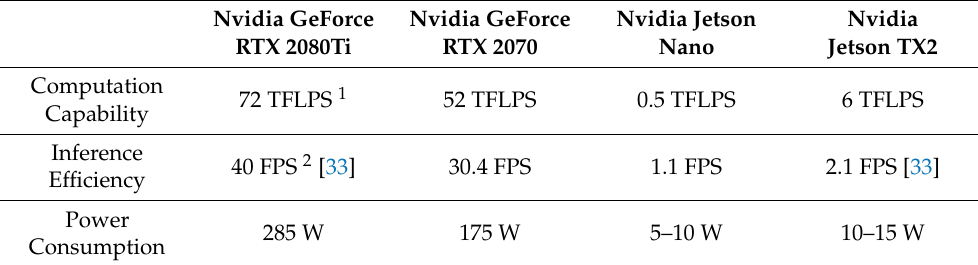
Table 7. Comparison FPS 1 of Nvidia GeForce and Jetson